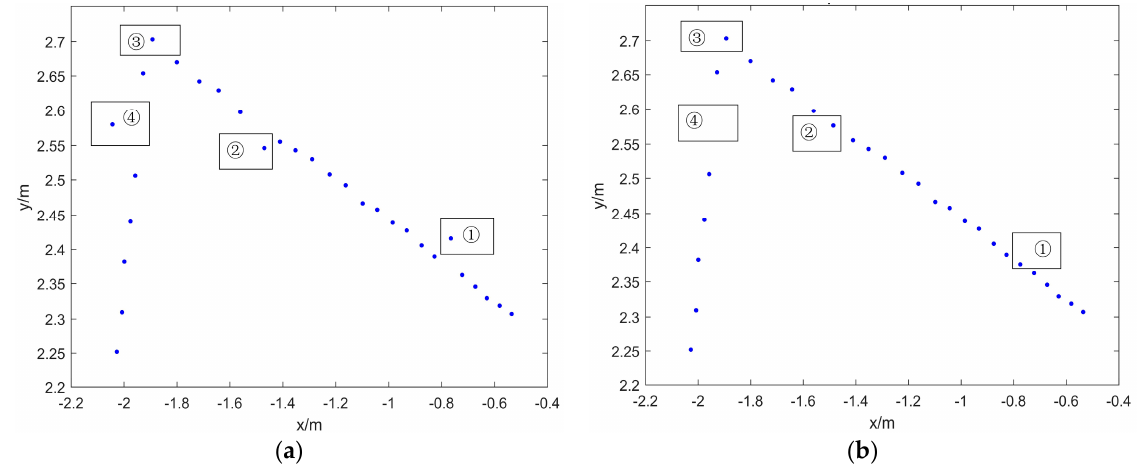
Figure 2. Radar data preprocessing: ( a ) raw data; ( b ) processed data.